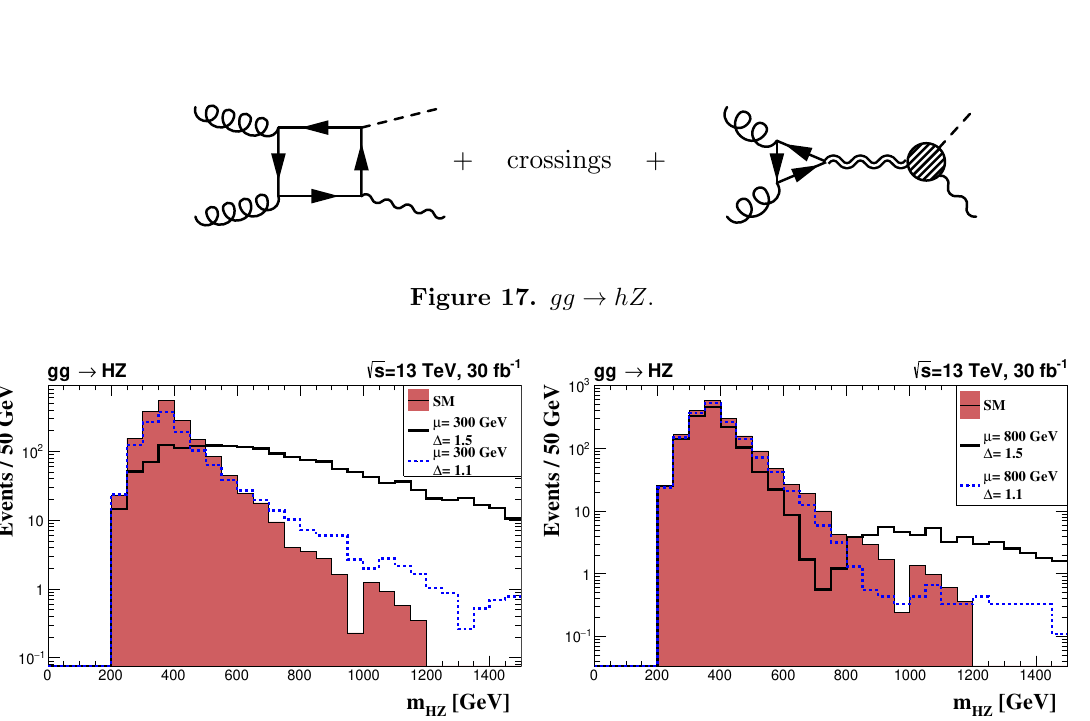
Figure 18. gg ! HZ , versus the invariant mass of Higgs and Z boson, m HZ